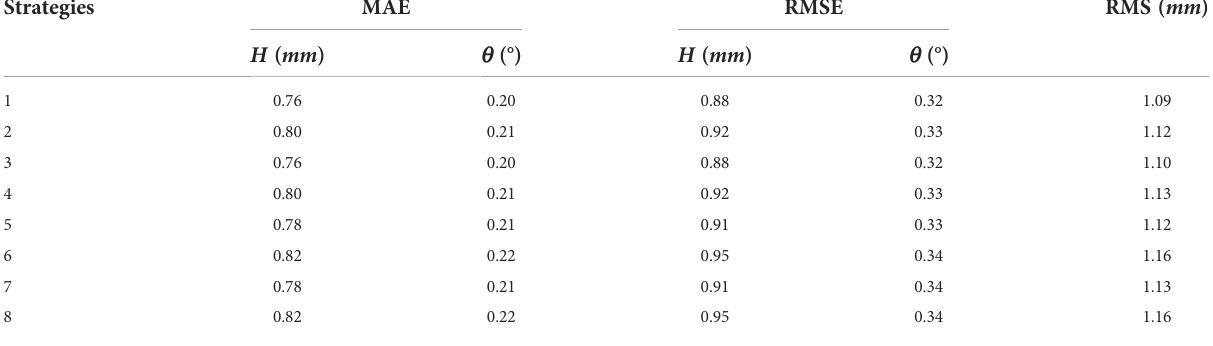
TABLE 5 Differences between SOs and re-estimated HCs of K 1 constituent.